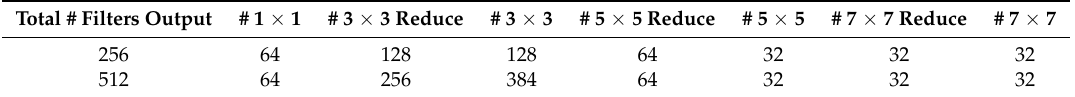
Table 3. The number of filters for each type of convolution in the Inception modules. The “n ×